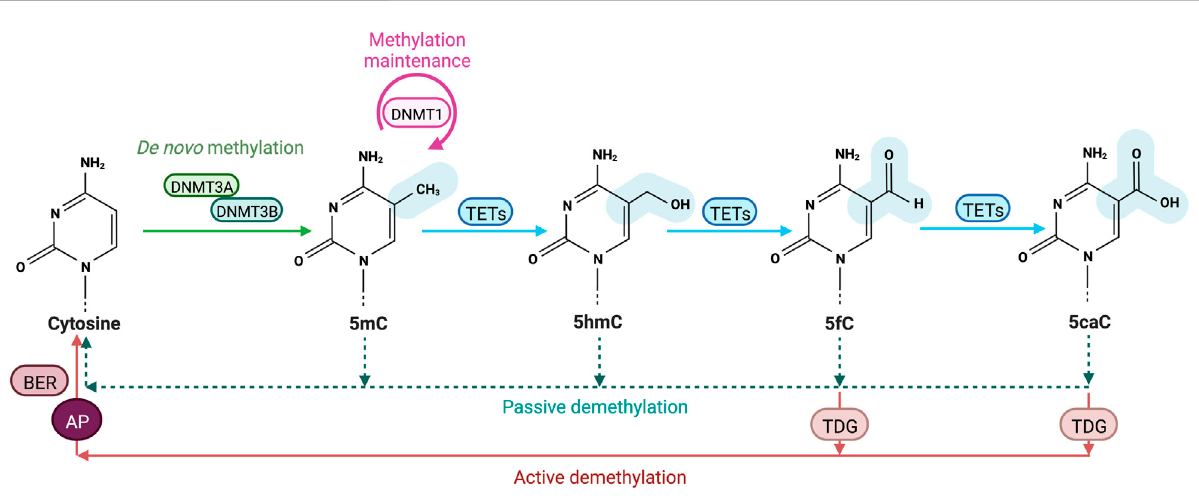
Cytosine methylation and oxidation cycle. In mammals, DNA methyltransferases (DNMTs) are responsible for the addition of a methyl group to the C5 position of cytosines to form 5-methylcytosines (5 mC). DNMT3A and DNMT3B drive de novo methylation during development, while DNMT1 is involved inmaintaining DNA methylation by copying methylation patternsonto thenewly replicated DNAstrand. DNA methylation can be reversed in a passive way through replication-dependent dilution in absence of DNMT1. DNA demethylation can also occur actively, through Ten eleven translocation (TET) proteins that oxidize successively 5 mC into 5-hydroxymethylcytosine (5hmC), 5-formylcytosine (5 fC) and 5- carboxylcytosine (5caC) and the replacement of the oxidized bases 5 fC and 5caC by an unmodi fi ed cytosine through thymine DNA glycosylase (TDG)-mediated abasic site (AP) formation and base excision repair